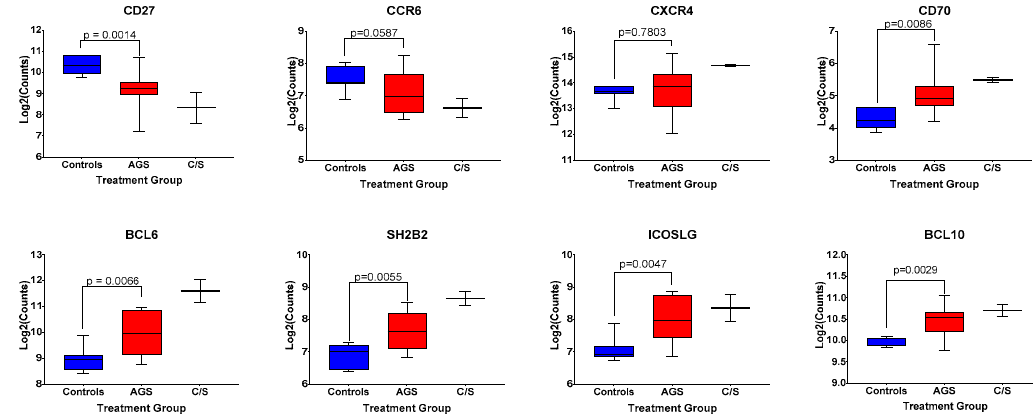
Figure 6. Normalized expression levels of select genes associated with B cell function among control, alpha-gal-sensitized but asymptomatic, and AGS subjects. p values were generated using an unpaired t test comparing control to AGS, with p < 0.05 considered statistically significant. Due to the small sample size, the sensitized but asymptomatic group was excluded from statistical analysis.